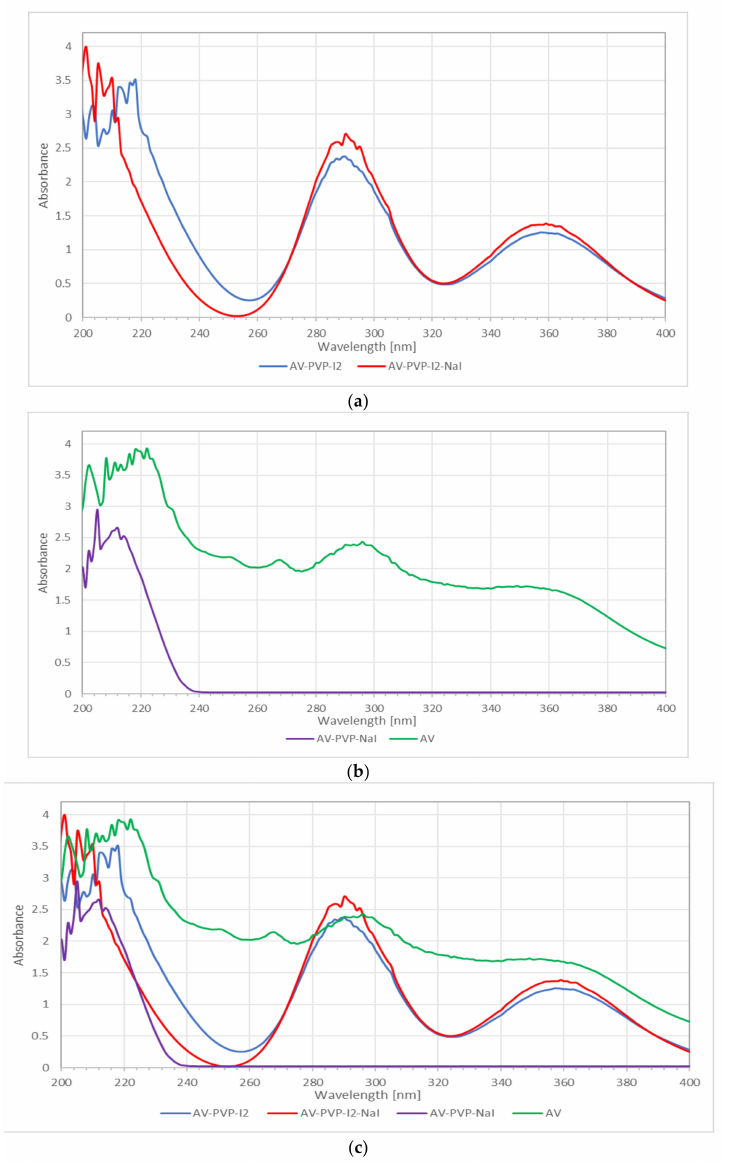
Figure 4. Ultraviolet-visible (UV-vis) spectrometric analysis of the samples. From up to down: ( a ) AV-PVP-I 2 and AV-PVP-I 2 -NaI; ( b ) AV and AV-PVP-NaI; ( c ) AV, AV-PVP-I 2 and AV-PVP-I 2 -NaI, and